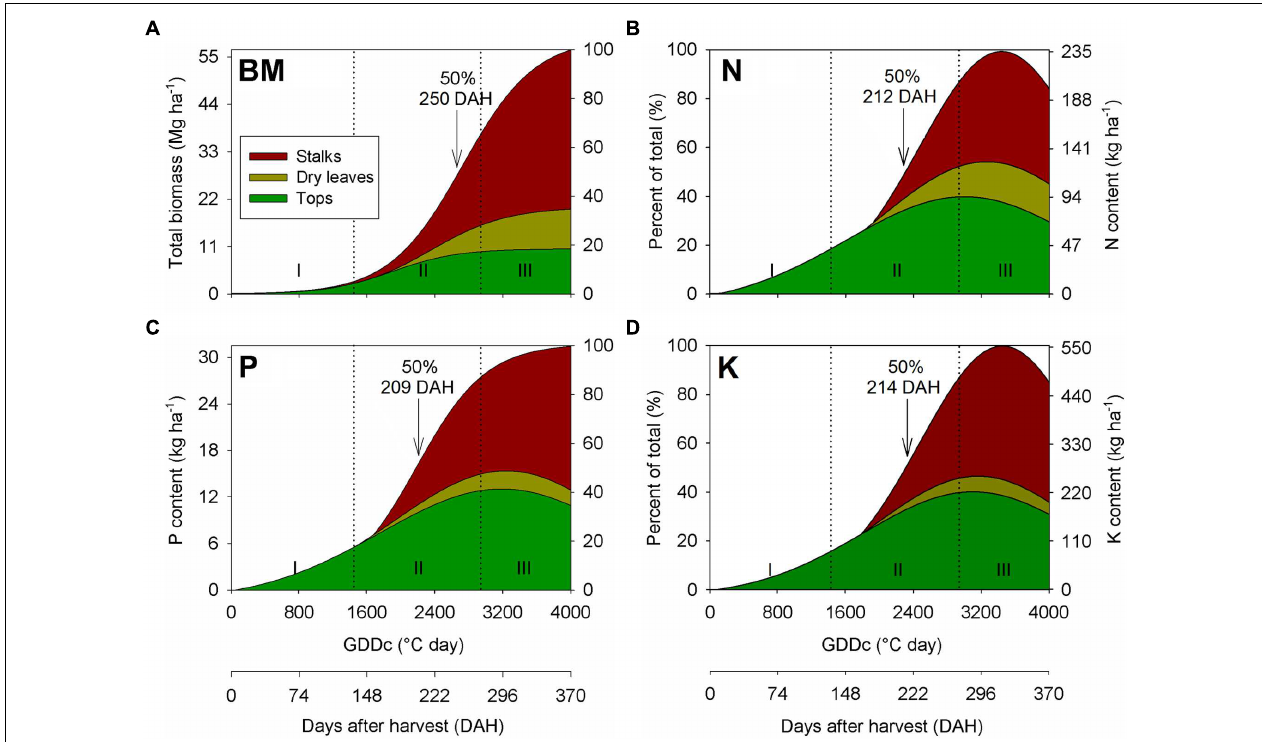
FIGURE 2 | Seasonal aboveground biomass (BM; A), nitrogen (N; B), phosphorus (P; C), and potassium (K; D) accumulation and partitioning in stalks, dry leaves, and tops of sugarcane during a first ratoon growing season, in overall for all three site-years located in the Southeast region of Brazil. Arrows indicate when sugarcane BM and nutrient accumulation achieved 50% relative to its final content at harvest